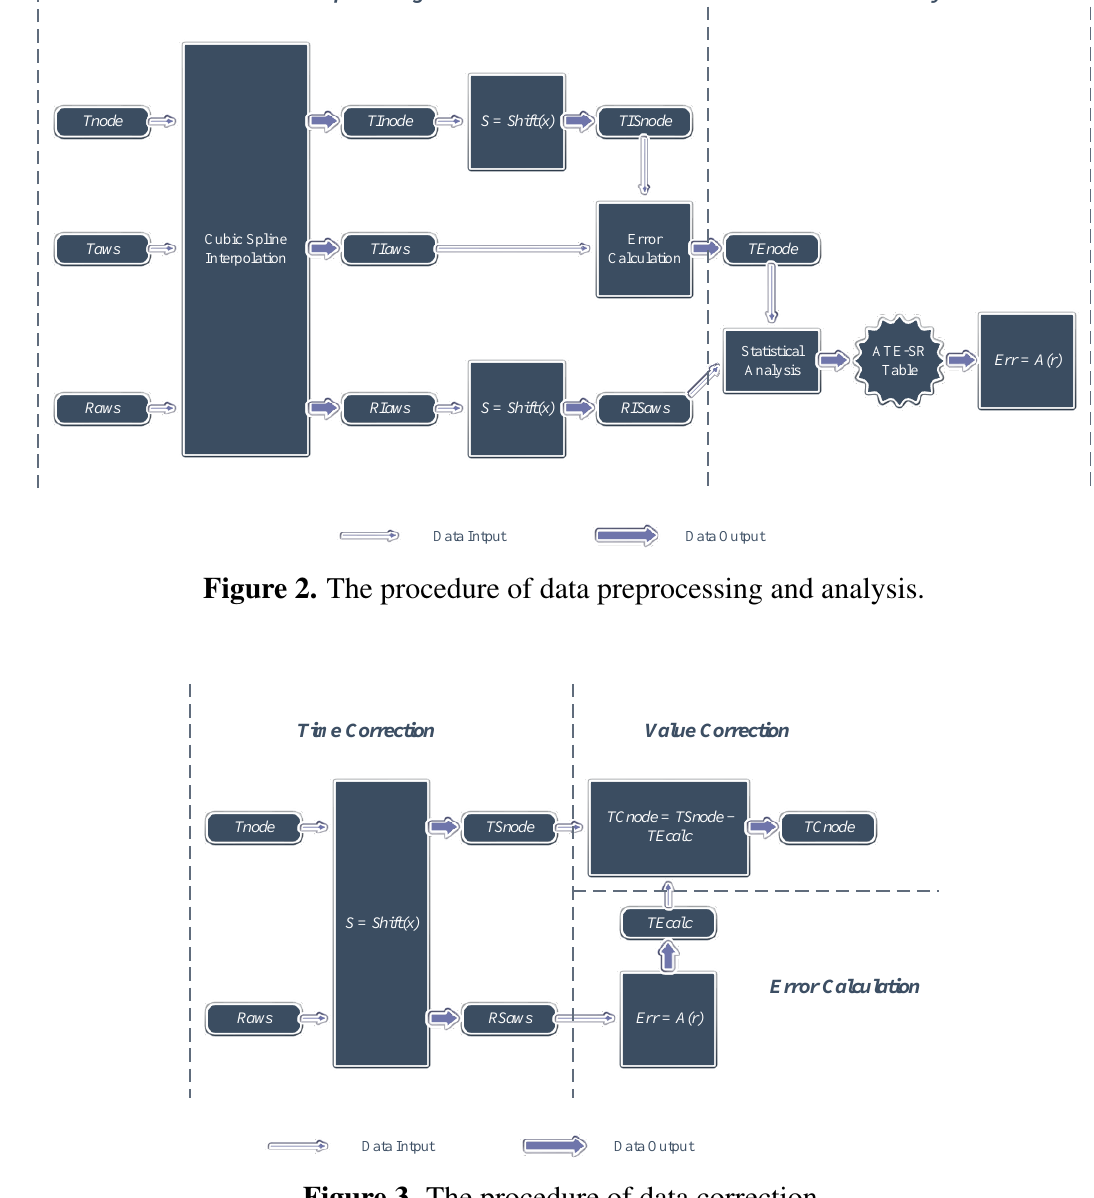
Figure 3. The procedure of data